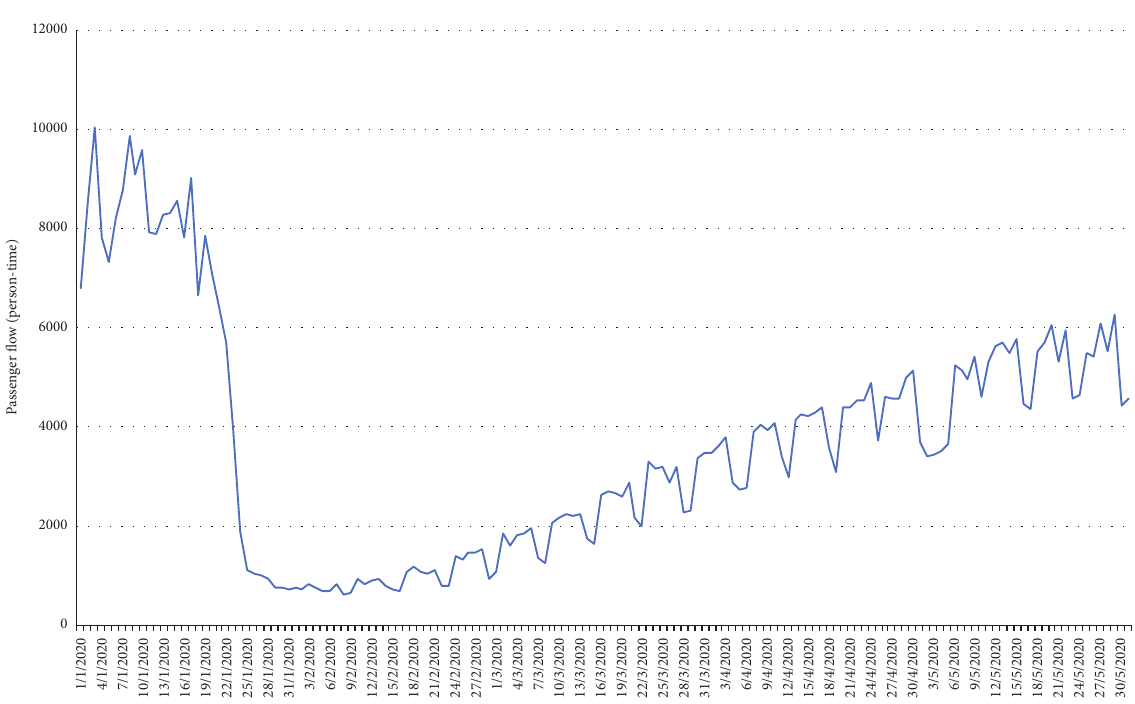
Figure 1: Passenger volume of the No. 428